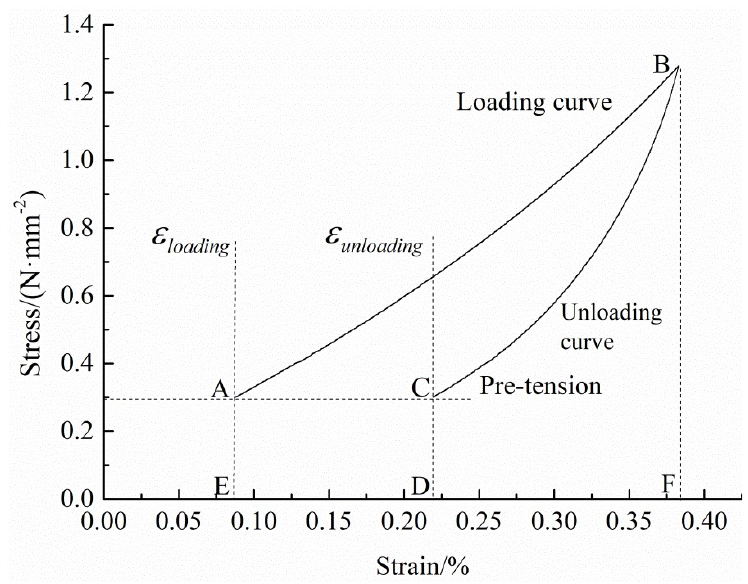
Figure 3. Level 2 stress–strain curves of the K 1 warp specimen.